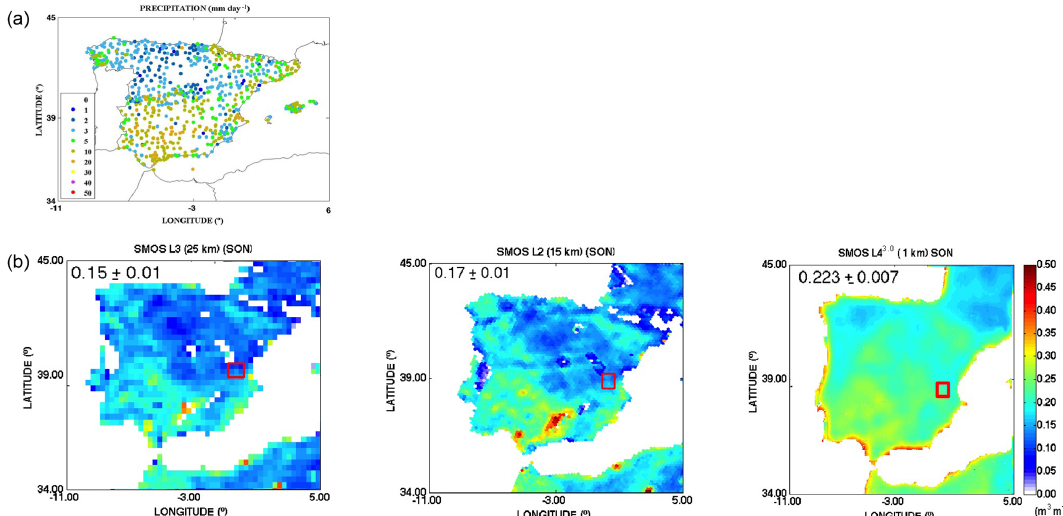
Figure 2. (a) spatial distribution of precipitation over the Iberian Peninsula from the network of rain gauges of AEMET. The period of September to November (SON) 2012 is shown. (b) spatial distribution of SMOS-derived soil moisture over the Iberian Peninsula (merged product: ascending and descending orbits, days with areal coverage higher than 50% are considered).